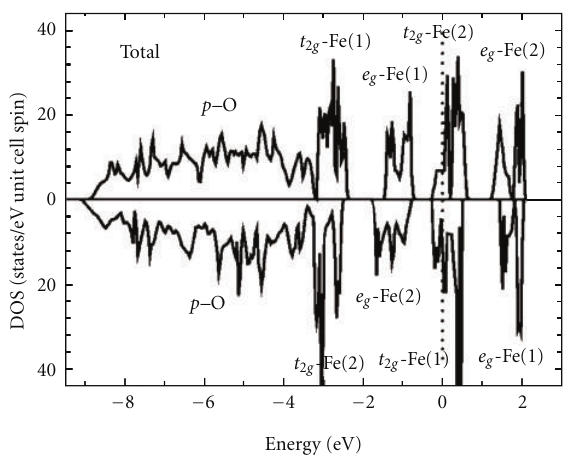
Figure 14: Total density of states (DOS) obtained from the LSDA calculations for the low-temperature P 2 1 /c phase of Fe 2 OBO 3 [211]. The top of the valence band is shown by dotted